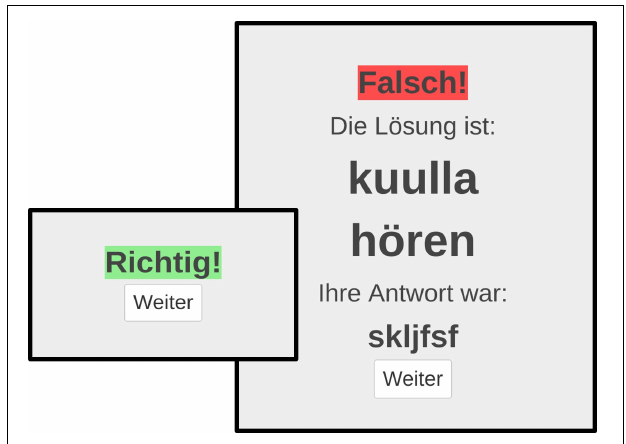
FIGURE 2 | Screenshots showing feedback screens as they were displayed to participants in the learning application. On the left side is an example of the feedback for correct answers, and on the right side is an example of corrective feedback in case of a wrong response, which also shows the complete word pair and the wrong answer the participant gave. Translation for German terms: “Falsch” = “wrong,” “Richtig” = “correct,” “Die Lösung ist” = “the solution is,” “Ihre Antwort war” = “your answer was,” “Weiter” =